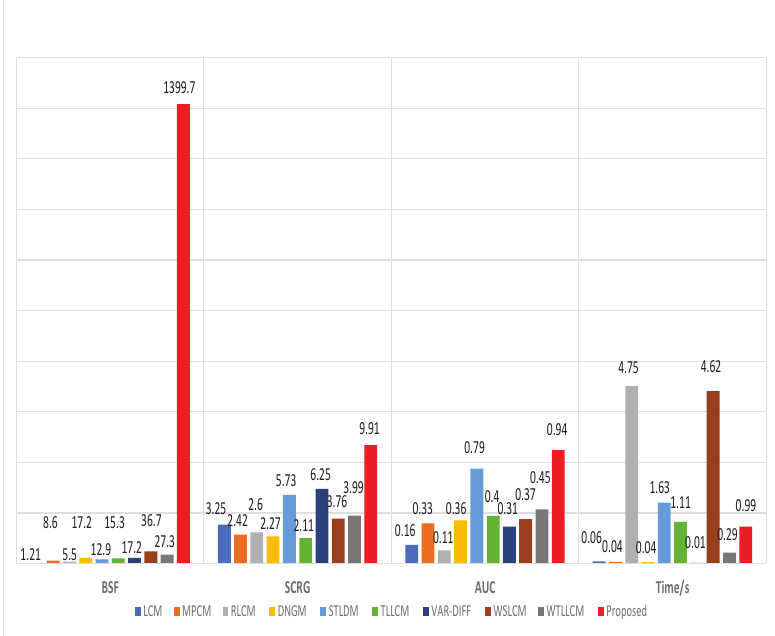
Figure 24. The histogram of the four evaluation indicators for several